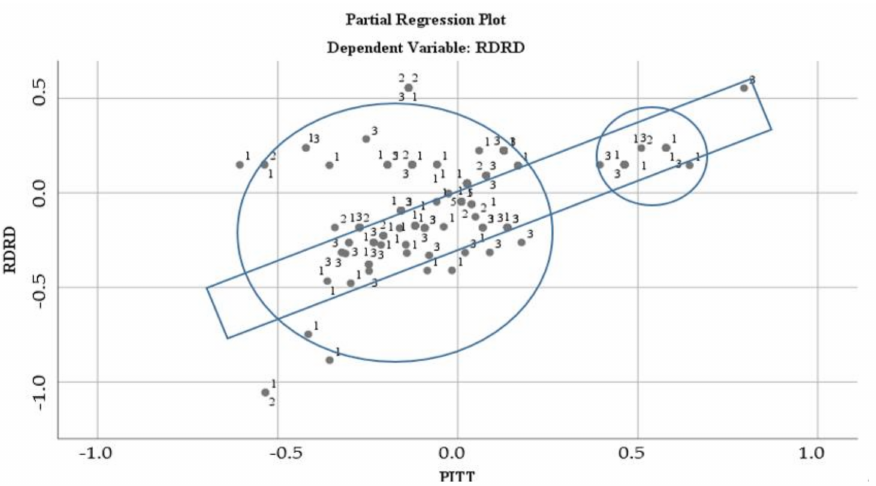
Figure 12. Regression analysis for PITT.